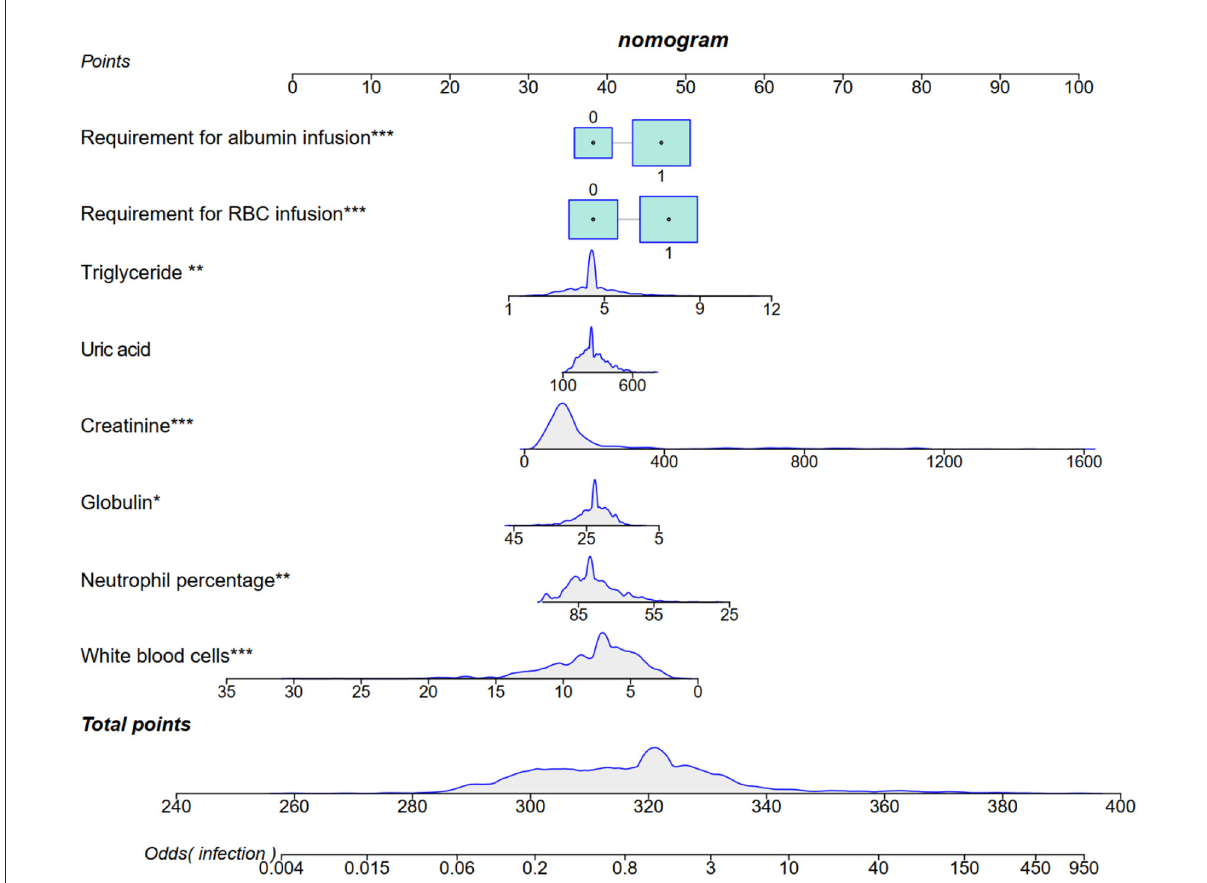
FIGURE4 A nomogram to predict infectious diseases was developed using the predictors selected using LASSO. * P < 0.05, ** P < 0.01, *** P < 0.001. LASSO, Least Absolute Shrinkage and Selection Operator.